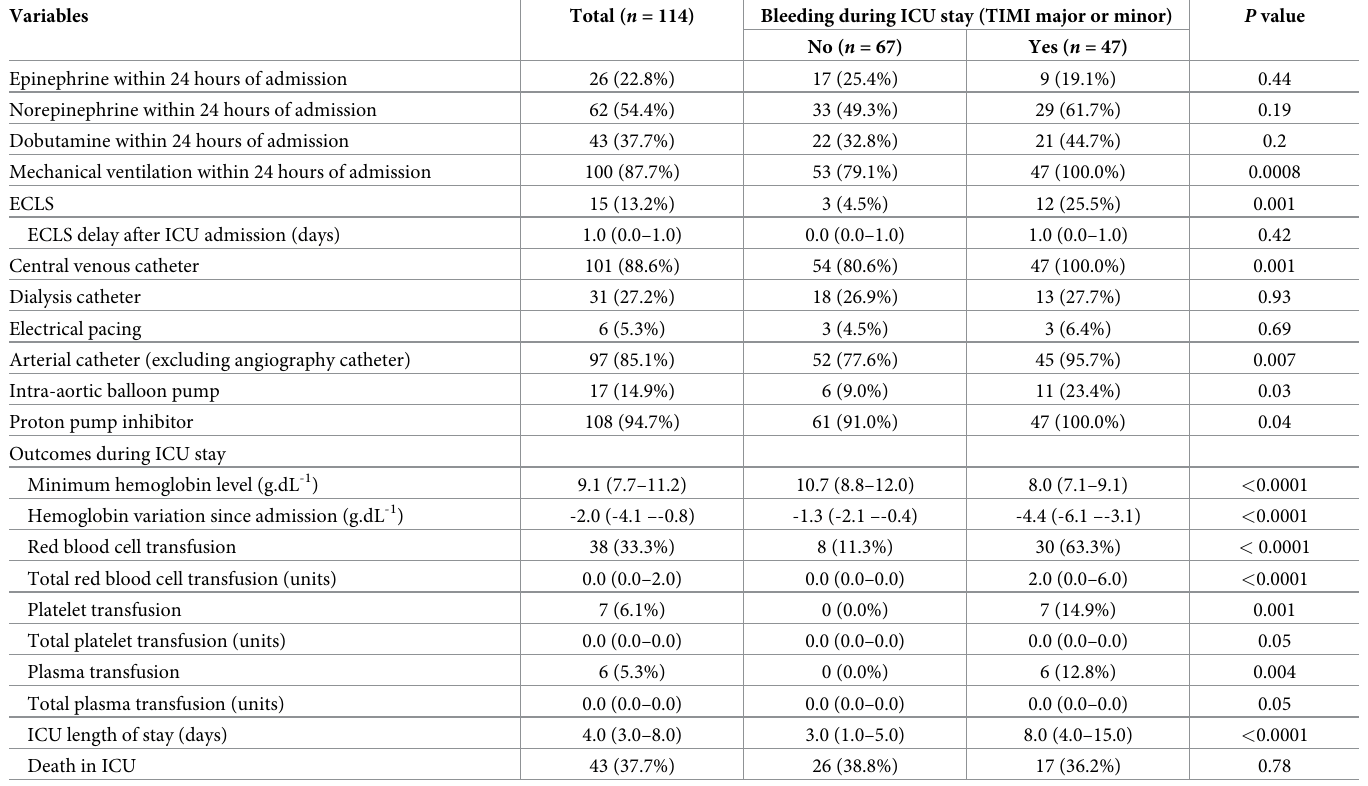
been conducted, this practice is discouraged due to a lack of safety/efficacy data [4,29–31]. Our study focused on the intensive care management of 155 ICU patients diagnosed with severe forms of ACS. After propensity score matching, 57 patients treated with ticagrelor were compared to 57 patients treated with clopidogrel. All of our study patients were critically ill, as evidenced by the SAPS II (61.5 (41.0–85.0)) and by other indicators such as the rate of cardiac Table 4. Factors potentially associated with bleeding during ICU